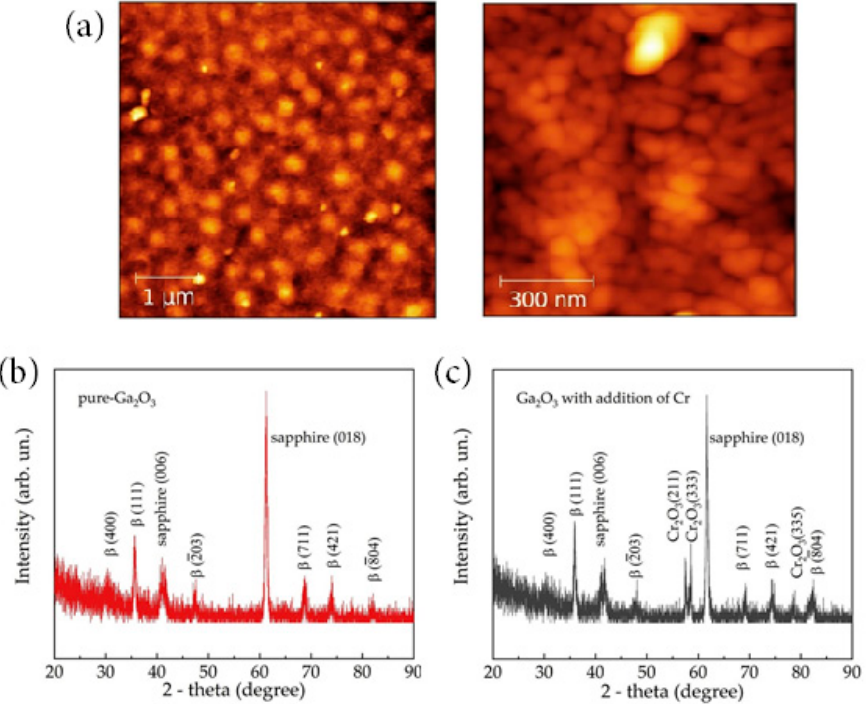
Figure 5. ( a ) AFM images of the Cr ‐ doped Ga 2 O 3 sputtering thin film [87]. XRD patterns of ( b ) pure Ga 2 O 3 thin films and ( c ) Cr ‐ doped Ga 2 O 3 thin films [87]. Copyright 2020